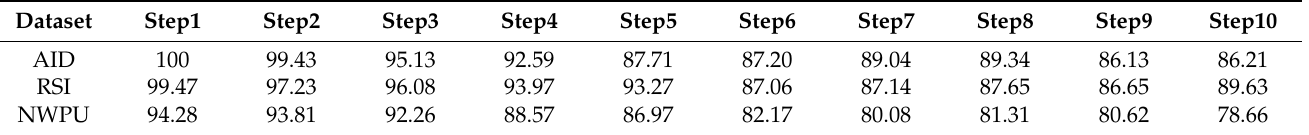
Table 5. Overall accuracy of class incremental learning on each of the three